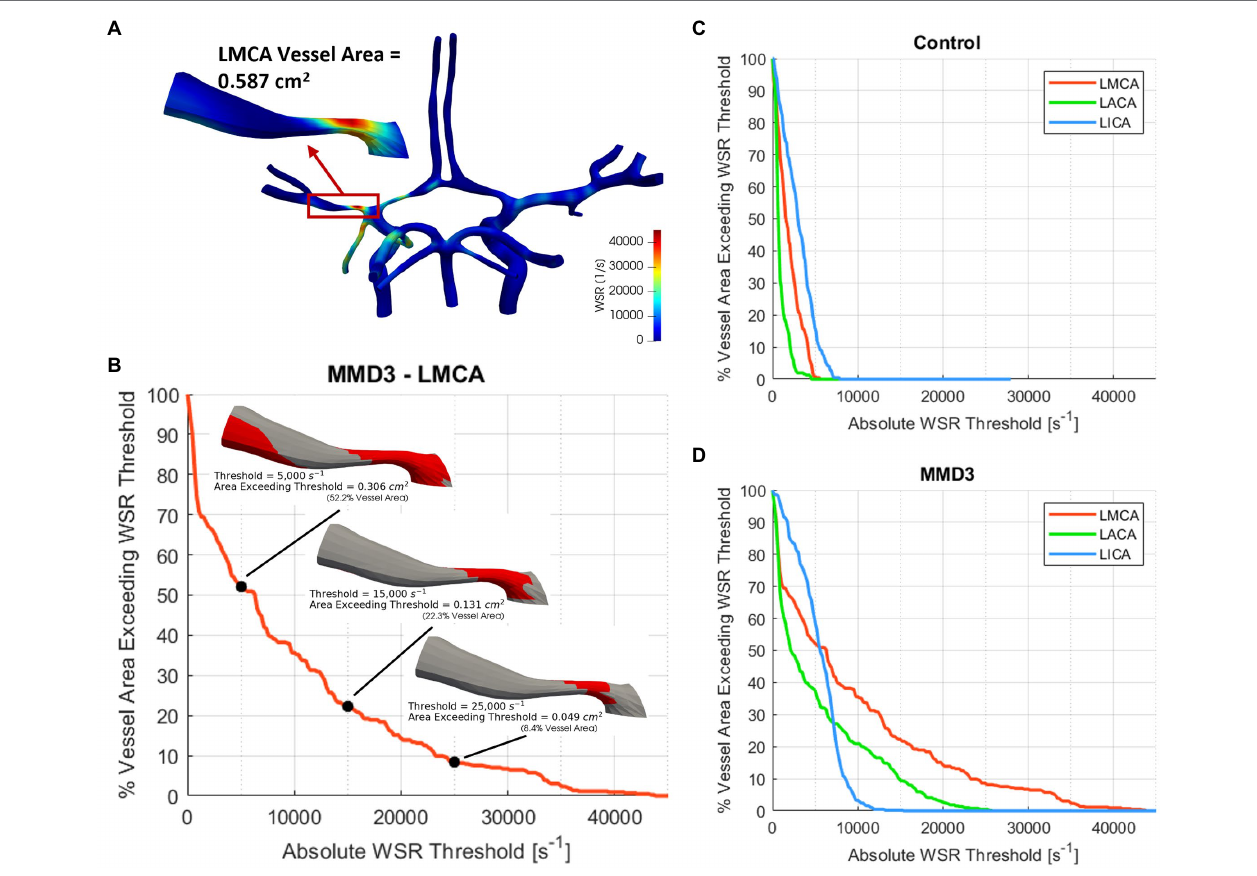
FIGURE 3 | (A) Construction of WSR curve. First, a vessel segment is extracted from the model and the total surface area is measured. A WSR threshold is set and the surface area that exceeds this threshold is quantified and then divided by the vessel’s total surface area to obtain percent vessel area exceeding WSR threshold, which is then calculated for multiple threshold values ranging from 0 to 100,000 s − 1 with an increment as low as 100 s − 1 to generate the WSR curve (B) . The WSR curves for the left and right ICAs, MCAs, and ACAs are shown for (C) the control subject and (D)